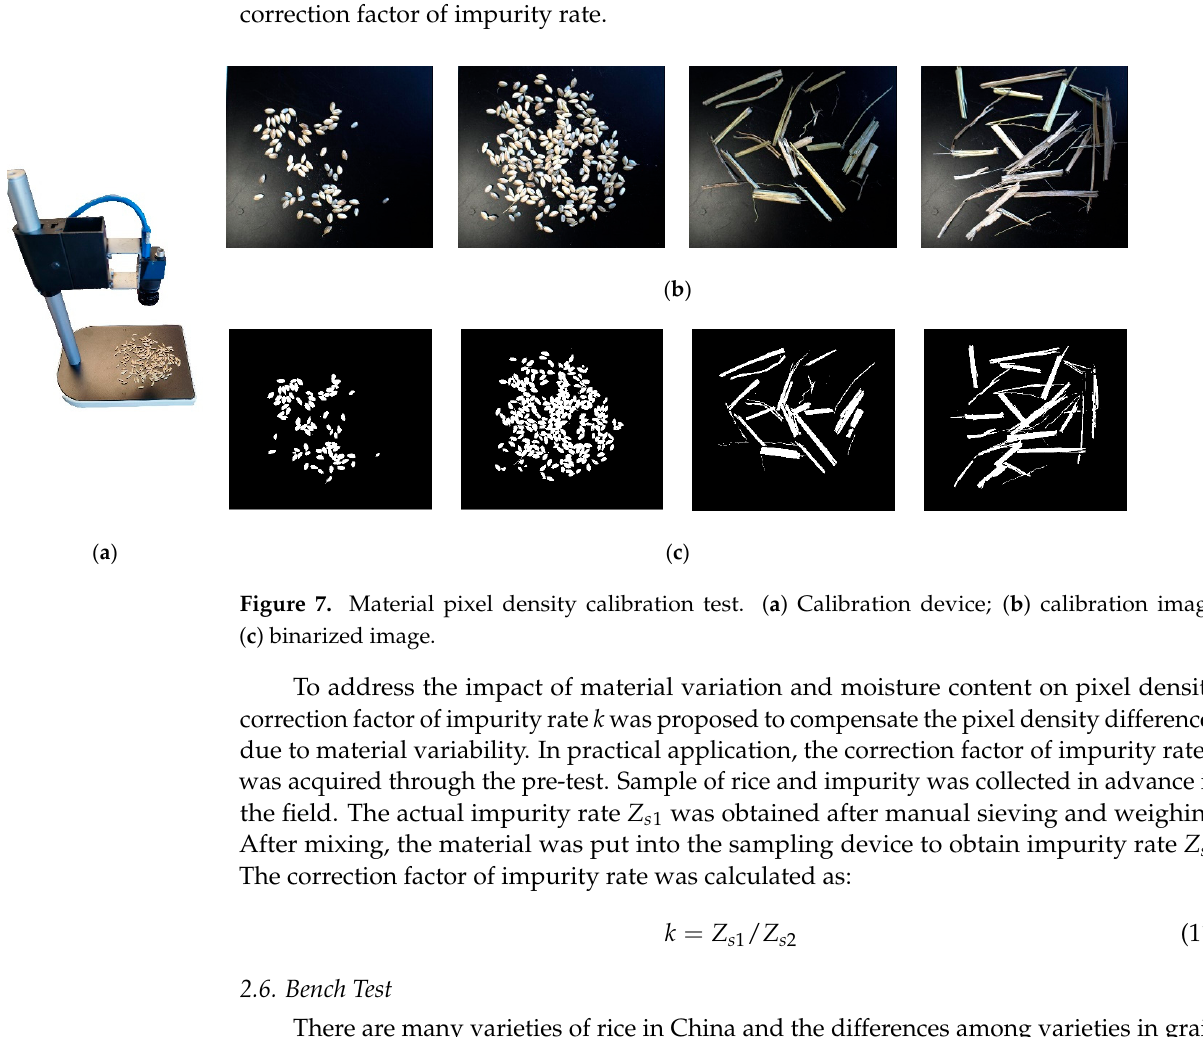
( c ) Figure 8. Bench test. ( a ) Test bench 3D model; ( b ) test bench physical picture; ( c ) material collection. 2.7. Field Test The field experiment was carried out in Hongqi Farm, Taizhou City (119.923° E, 32.456° N), Jiangsu Province, November 2021. The test machine was Thinker 4LZ-5.0 type